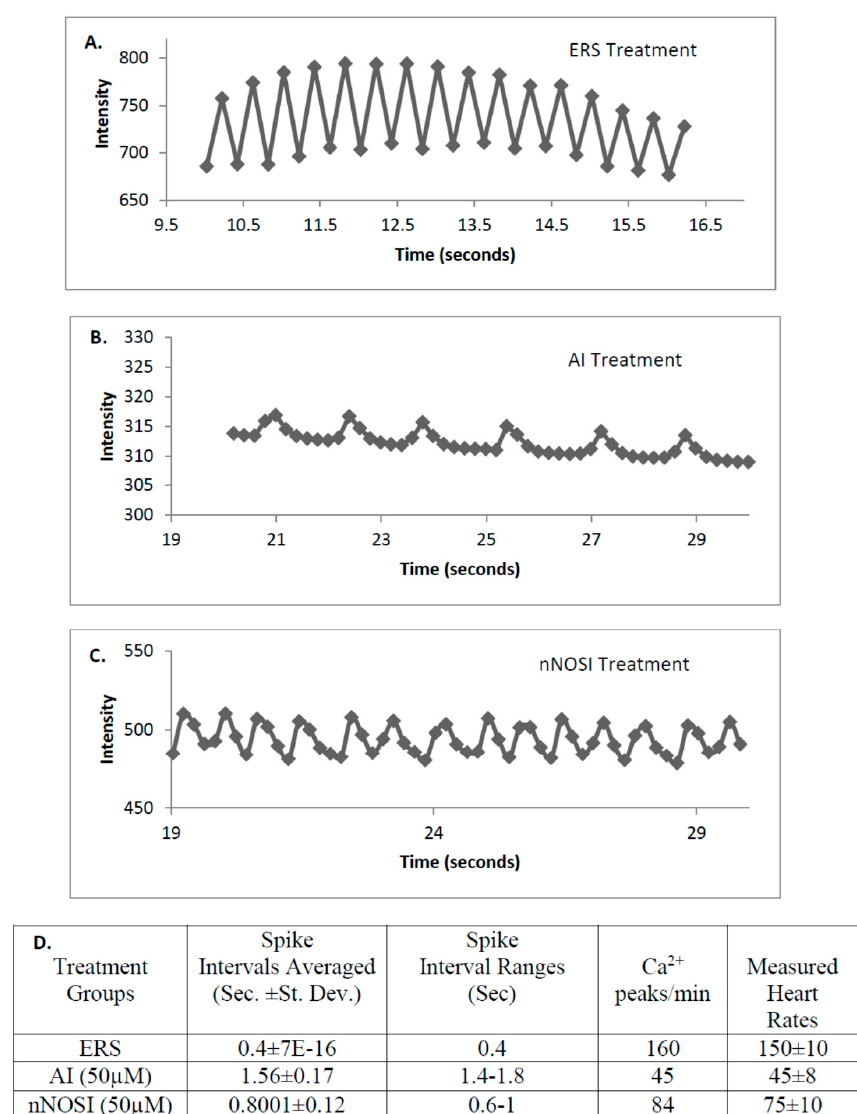
Figure 5. The effects of various treatments on selected representative fish hearts as measured by Ca 2+ flux patterns in the Tg(cmlc2:gCaMP) line of transgenic fish after 4 days of treatment beginning at 48 h post fertilization (hpf). ( A ) This figure shows the Ca 2+ flux that takes place in a control zebrafish heart treated in ERS solution. Note the regularity of the CA 2+ flux spike patterns represented by the peaks and valleys. For example, this regular spike interval occurs every 0.4 s (see comparisons in Figure 3D. below); ( B ) This figure shows the calcium flux in a zebrafish heart treated with the aromatase inhibitor (AI) 4-androstene-3,17-dione. Note that peaks are even farther apart than that of nNOSI and ERS controls. The time difference between peaks ranges between 1.4–1.8 s, which are more than four times longer than ERS controls; however, the spike patterns still remain more regular than their nNOSI treated counterparts (see comparisons in Figure 3C,D below); ( C ) This figure shows a more pronounced arrhythmia behavior exhibited by irregular calcium flux patterns in a zebrafish heart treated with 50 µ M nNOSI. When compared to ERS controls, the interval differences between peaks were observed to occur over a more extensive and irregular range of 0.6–1 s; ( D ) This table quantifies calcium flux values for the three fish seen in Figure 5A–C above. Specifically, the Ca 2+ peak values/min for all three fish matches very closely the actual measured heart rates (beats/minute) for comparable treatment groups throughout the study with the AI and nNOSI HRs in the arrhythmic range (<120 bpm, 45 ± 8 and 75 ± 10 bpm respectively, compared to 150 ± 10 for controls) and were further confirmed by their increased and more irregular Ca 2+ spike